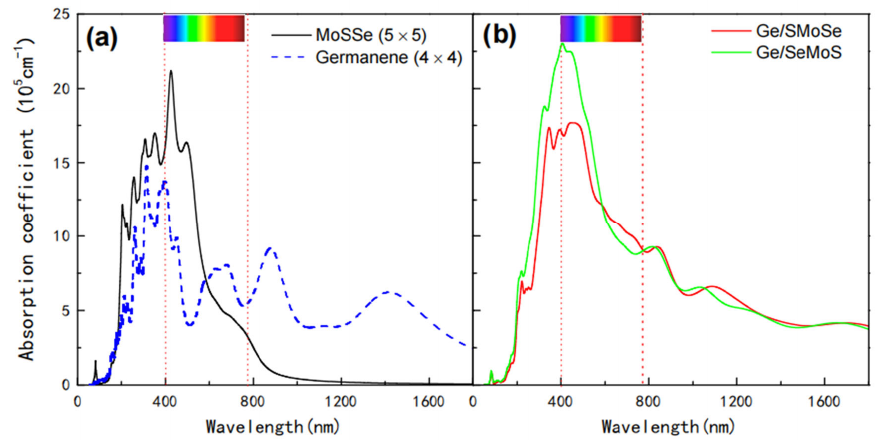
Figure 4. Optical absorption coefficients of ( a ) (4 × 4) germanene and (5 × 5) MoSSe; ( b ) Ge/SMoSe and Ge/SeMoS heterostructures.